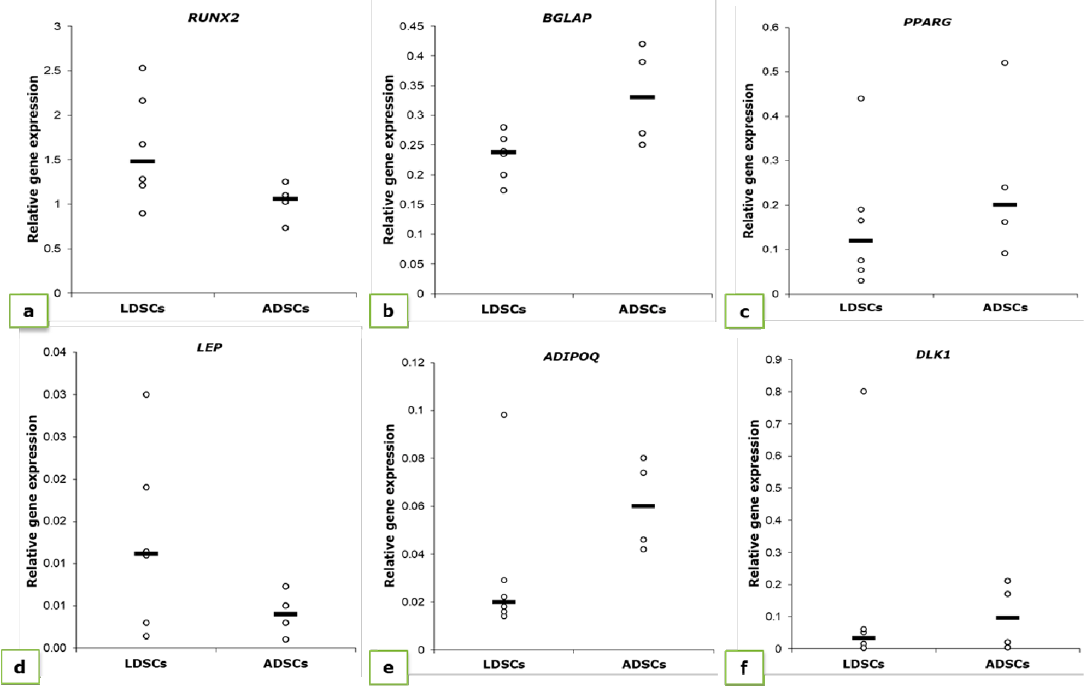
Figure 3. Relative expression of RUNX2 ( a ), BGLAP ( b ), PPARG ( c ), LEP ( d ), ADIPOQ ( e ) and DLK1 ( f ) genes in LDSCs and ADSCs at passage 2 (day 0 in differentiation assays), normalized to GAPDH ; significant difference between cells was noticed for RUNX2 and BGLAP expression ( p < 0.05); scatterplots with median; n (LDSCs) = 6 and n (ADSCs) = 4 for all genes.